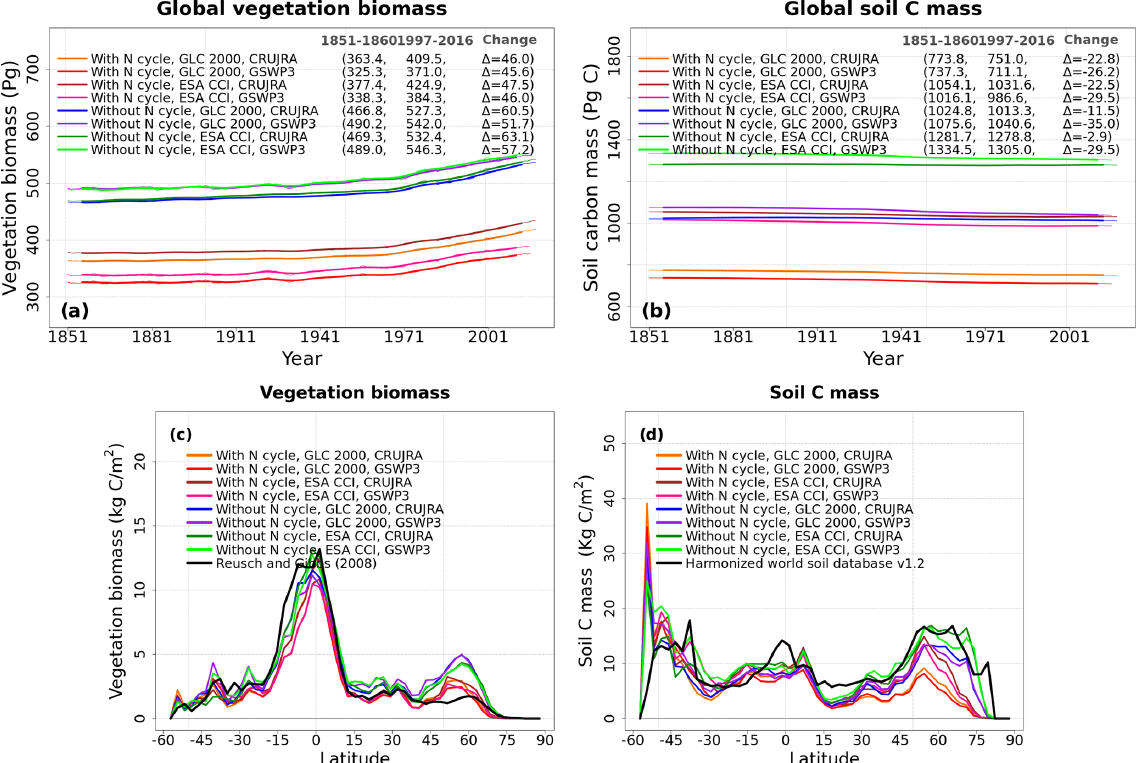
Figure A6. Time series of simulated global annual vegetation carbon mass (a) and soil carbon (b) from the eight simulations summarized in Table 1. The global totals exclude Greenland and Antarctica; (c) and (d) show the zonally averaged values of vegetation carbon mass and soil carbon mass over land from the eight simulations averaged over the 1997-2016 period. The thin lines show the individual years, and the thick lines show their 11-year moving average in (a) and (b) . Model values averaged over the pre-industrial (1851–1860) and present-day (1997–2016) time periods, and their difference, are also shown in (a) and (b) .